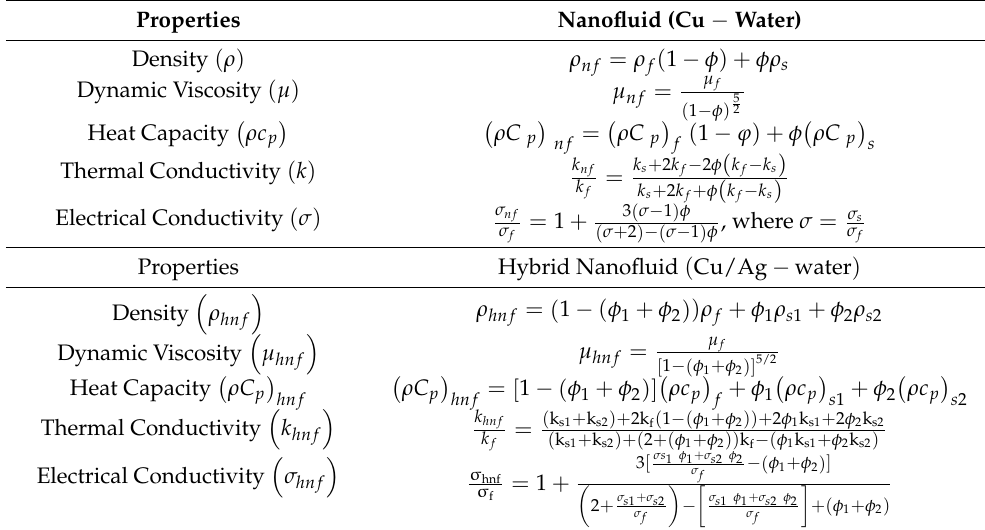
Table 2. Thermo-physical properties of conventional and hybrid nanofluid [10,55].